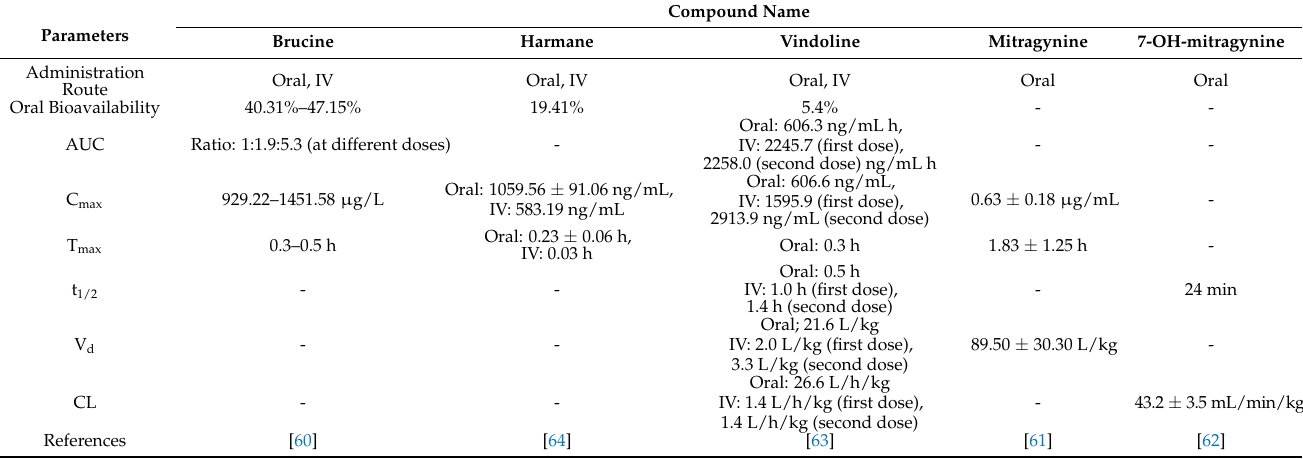
Table 2. Pharmacokinetic profiles of indole